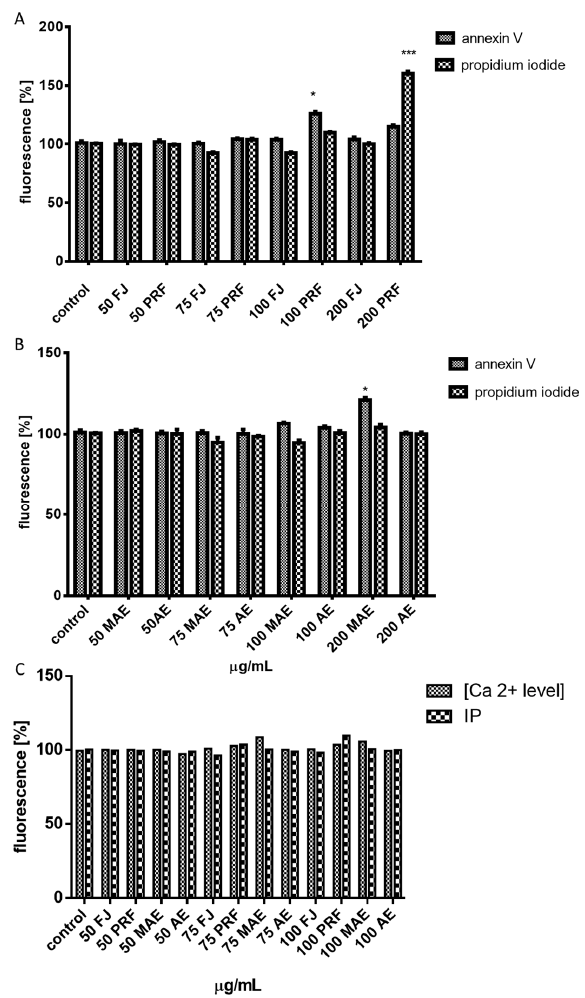
Figure 9. The influence of 24 h of exposure of juice (FJ) and PRF (phenolic rich fraction) ( A ), MAE (methanol-acetone extract) and AE (acetone extract) ( B ) on phosphatydylserine externalization on the outer membrane leaflet of apoptotic cells and membrane permeabilization detected with Annexin-V-FITC (fluorescein isothiocyanate) assay kit and propidium iodide staining ( A , B ); the extracts’ influence on intracellular calcium [Ca 2 + ] level detected with Fluo-8 assay with simultaneous monitoring of possible cell membrane permeabilization based on propidium iodide (PI) DNA intercalation ( C ). Control cells were not exposed to any compound but the vehicle; values are means ± standard deviations from at least three independent experiments; statistical significance was calculated versus control cells (untreated) * p ≤ 0.05, *** p ≤